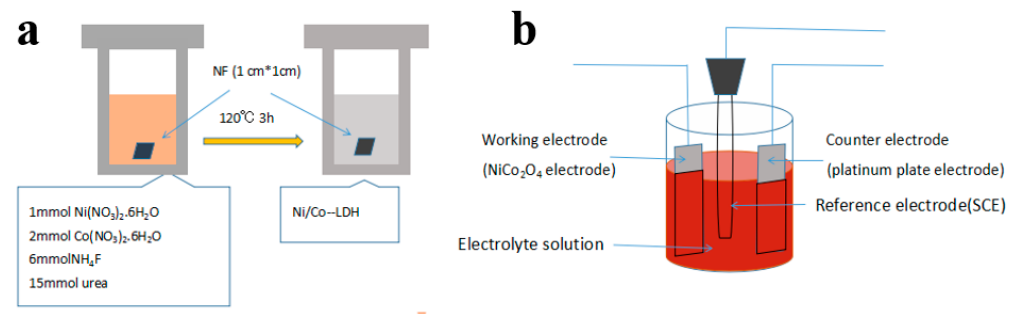
Figure 1. Schematic of the preparation of Co x Ni 1 − x (OH) 2 nanoflake arrays on Ni foam by ( a ) hydrothermal and ( b ) electrodeposition methods.